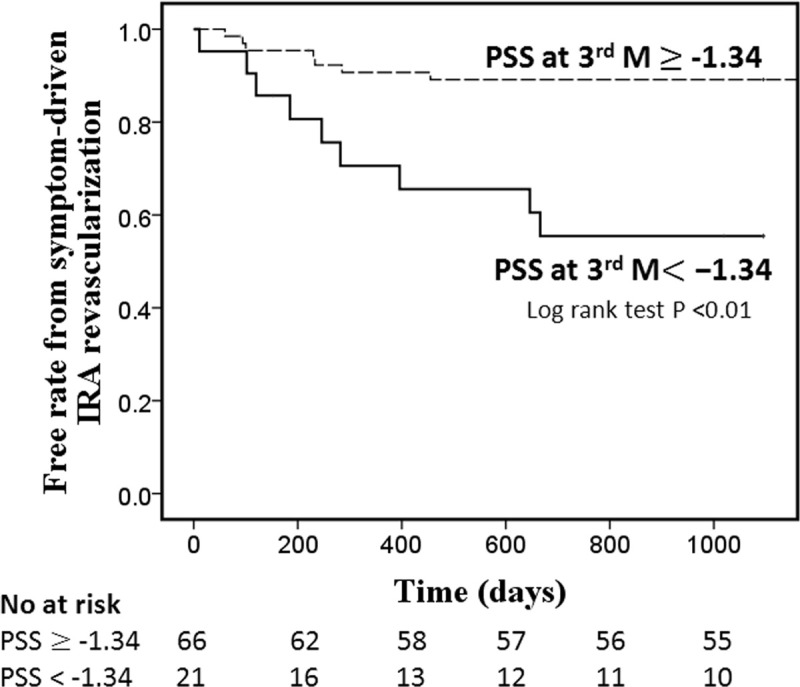
Kaplan-Meier curve for PSS at 3 months for symptom-driven infarct related artery revascularization.